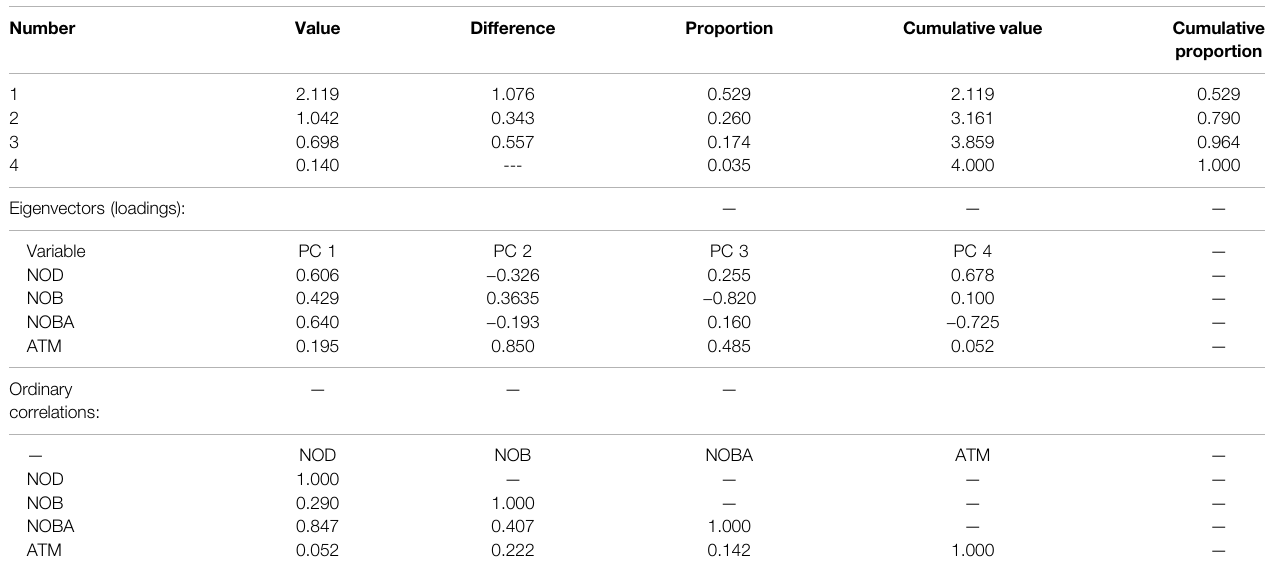
TABLE 3 | Results of PCA analysis.